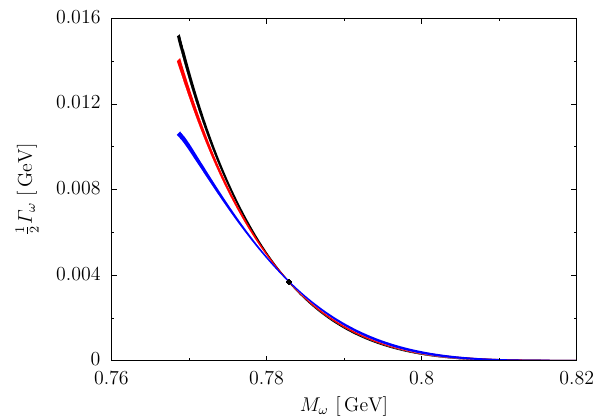
Fig. 7 Trajectory of the pion-mass-dependent ω mass and width in the complex-energy plane of 3 π → 3 π scattering for the three investigated scenarios: pure kinematics (black), 2-body FSI (red), and full 3-body FSI (blue). This plot can be compared with the one for the ρ resonance, seeFig.1.Thephysicalpointismarkedbytheblackdiamond.Theerror bands are generated by taking the uncertainties of the IAM phase shift δ( s ) , M ω ( M 2 ) , and ¯ Γ ω into account, see Fig. 2, Eq. (38), and Ref. [29] π